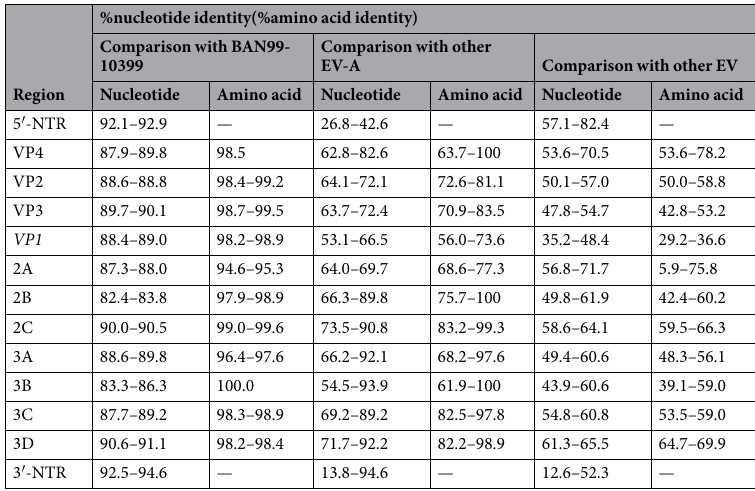
Table 1. Comparison among five EV-A90 strains from Xinjiang Uygur Autonomous region of China, the EV-A90 prototype strain (BAN99-10399) and other Enterovirus prototype strains in nucleotide sequence and deduced amino acid sequence